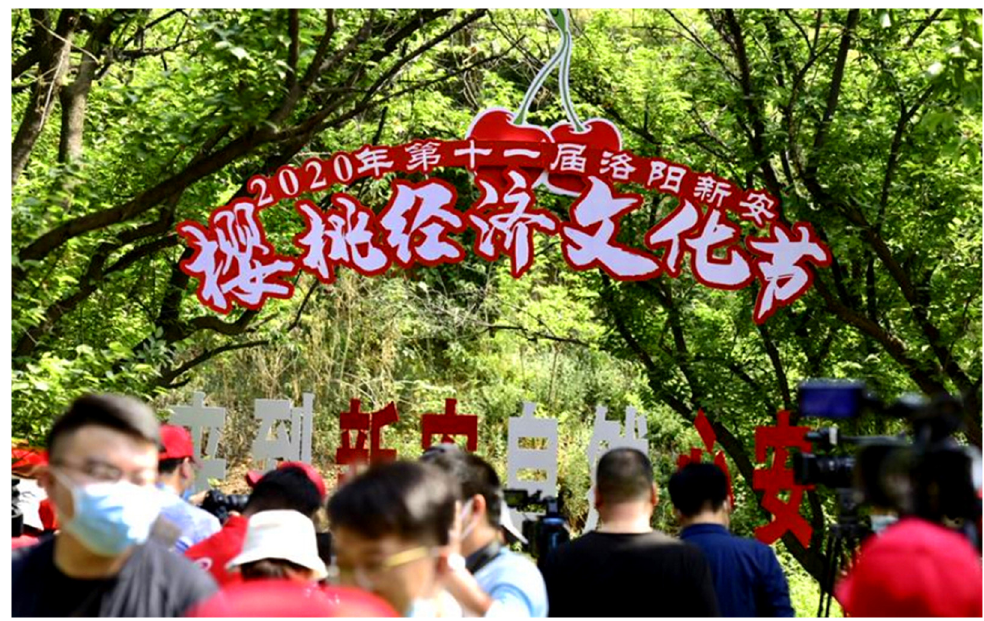
Figure 2. Xin’an Cherry Economy and Culture Festival (2020).